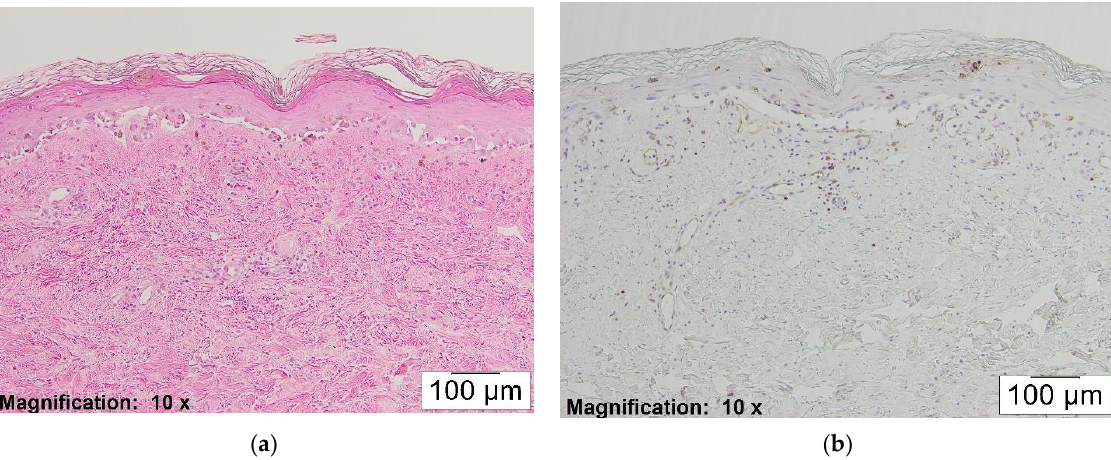
Figure 4. ( a ) H&E, ×10. This figure shows mycoplasma pneumonia induced EM. ( b ) CD123, ×4. This figure shows mild inflammatory infiltrate with pDCs in the same case (1+ staining pattern).